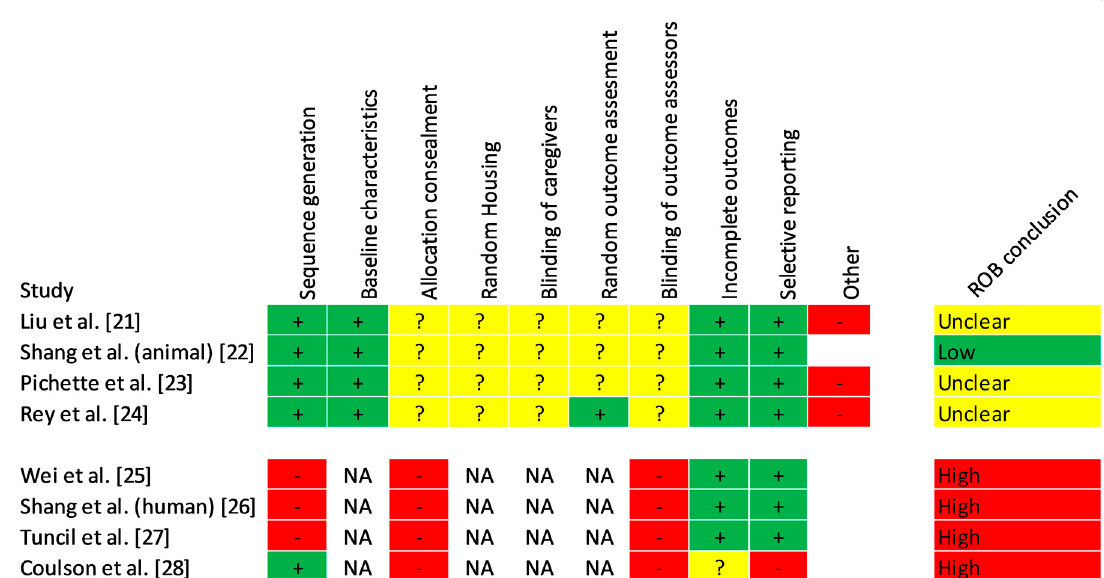
Figure 2. Risk of bias. ROB—risk of bias. NA—not applicable. The risk of bias was rated as “unclear” in three out of four animal studies. While all studies randomized animals into groups, and presented the baseline characteristics and outcomes appropriately, none of the studies reported on allocation concealment, random housing, blinding of the caregivers, or blinding and randomization of outcome assessment. Additionally, three out of four studies were downgraded for using only male animals. In human studies, the risk of bias was high in three non-randomized, non-blinded experimental studies that used convenience sampling and had small sample sizes, as well as in the fourth study, a non-blinded randomized controlled trial.